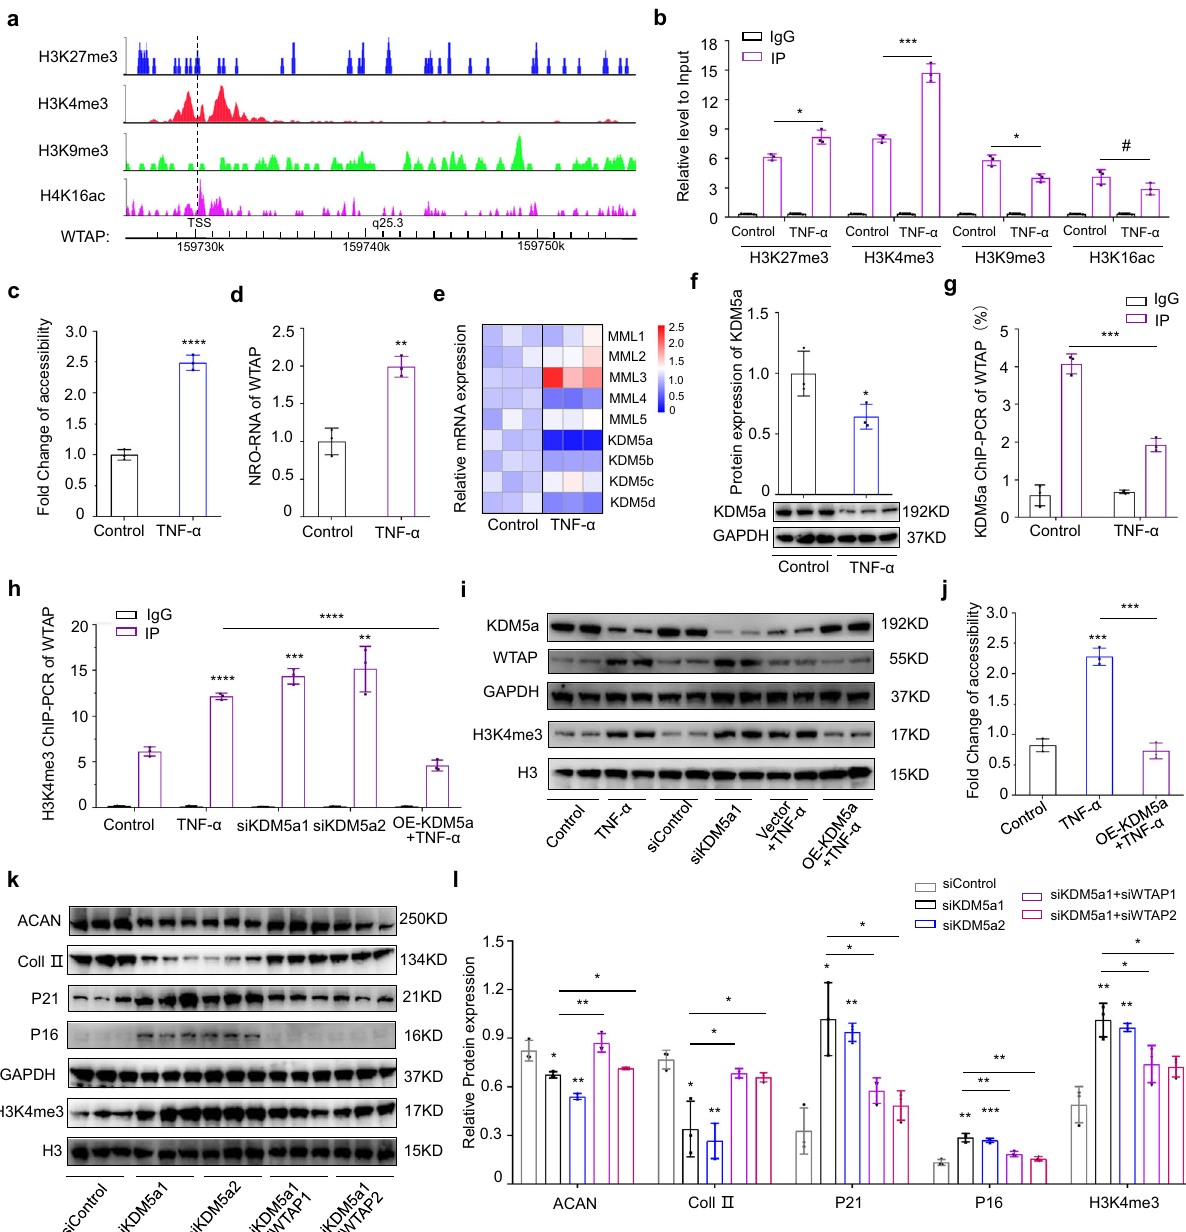
Fig. 4 WTAP upregulation is regulated by the epigenetic alteration of H3K4me3. a Prediction of Histone modi fi cation of the WTAP promoter using the WashU Epigenome Browser. b ChIP-PCR analysis of H3K27me3 ( P = 0.0106), H3K4me3 ( P = 0.0003), H3K9me3 ( P = 0.0102) and H4K16ac ( P = 0.0888) modi fi cation in the promoter of WTAP. Data are shown as the mean ± SD, n = 3, # NS, * P < 0.05, *** P < 0.001, two-tailed unpaired Student ’ s t test. c DNase I sensitivity assay to analyze the chromatin accessibility of WTAP ( P < 0.0001). Data are shown as the mean ± SD, n = 3, **** P <